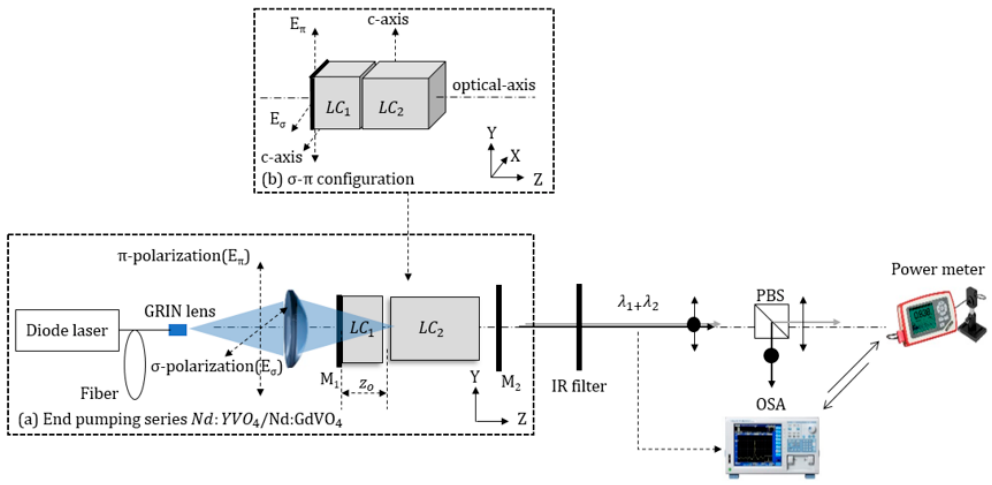
Figure 1. Experimental setup used in the measurements: ( a ) diagram for end pumping series crystals laser and ( b ) schematic diagram for σ - π configurations.